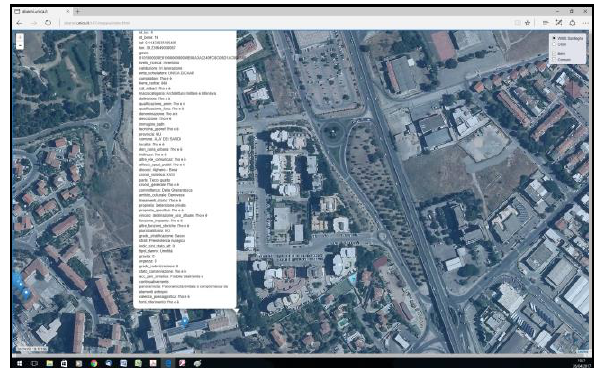
Figure 9. The WebGIS with orthophoto